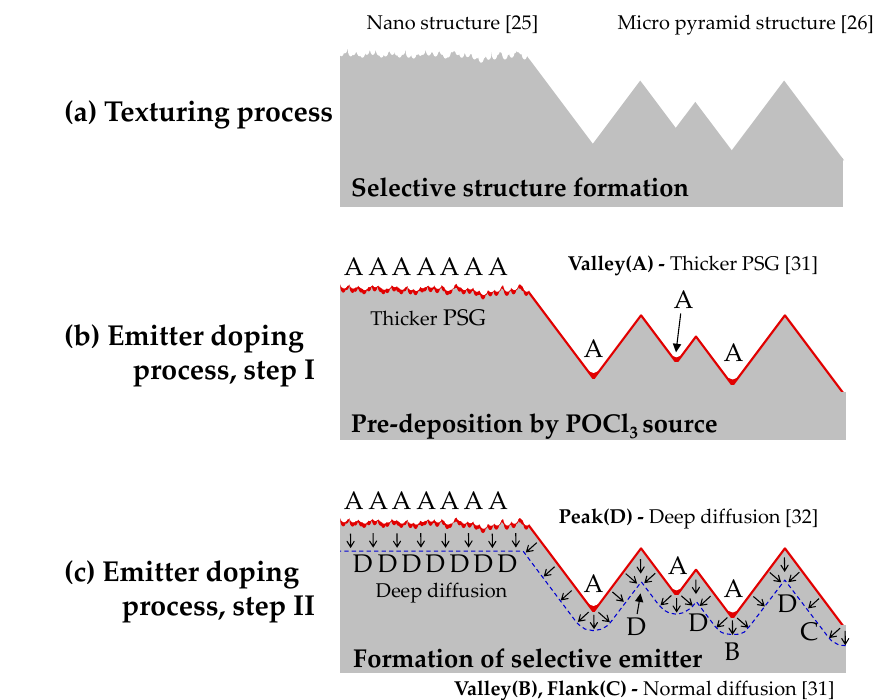
Figure 6. Formation mechanism of the novel selective emitter (SE) according to surface morphology, ( a ) selective structure formation on texturing process [25,26], ( b ) phosphorus pre-deposition on doping process [31], ( c ) phosphorus diffusion on doping process [31,32].